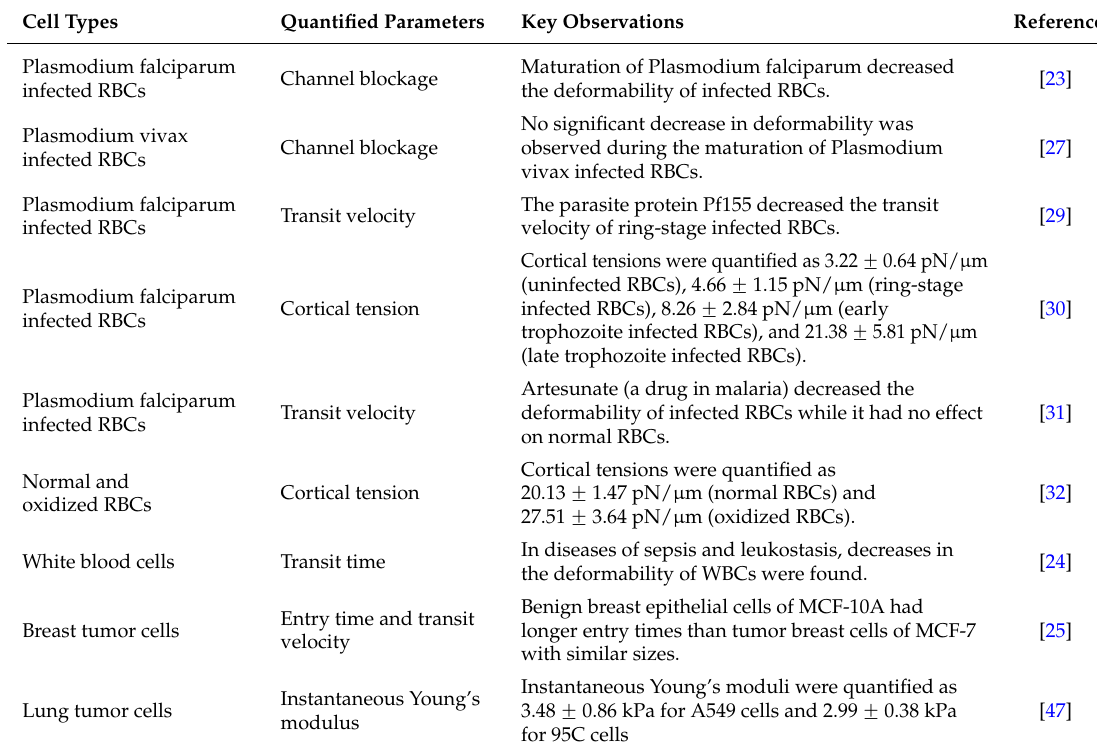
Table 1. Key developments in the field of microfluidic constriction channels enabling high-throughput cellular mechanical property